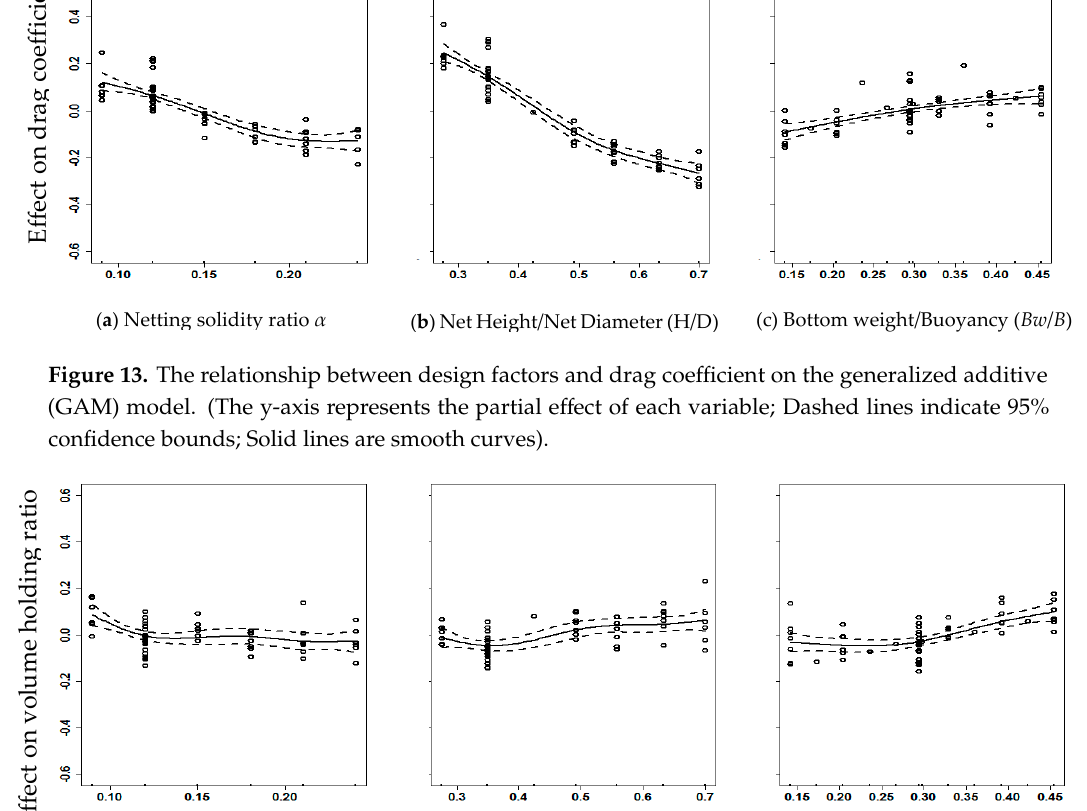
Table 3. Statistical results of GAM analysis for volume holding ratio.